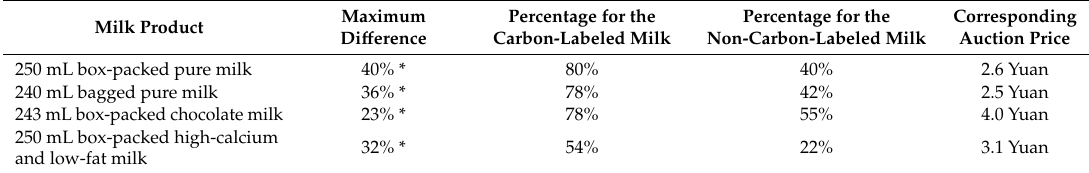
Figure 4. Variations in the percentage of bidders for the four milk products. Table 4. Maximum and minimum differences in the percentage of bidders and their corresponding prices.